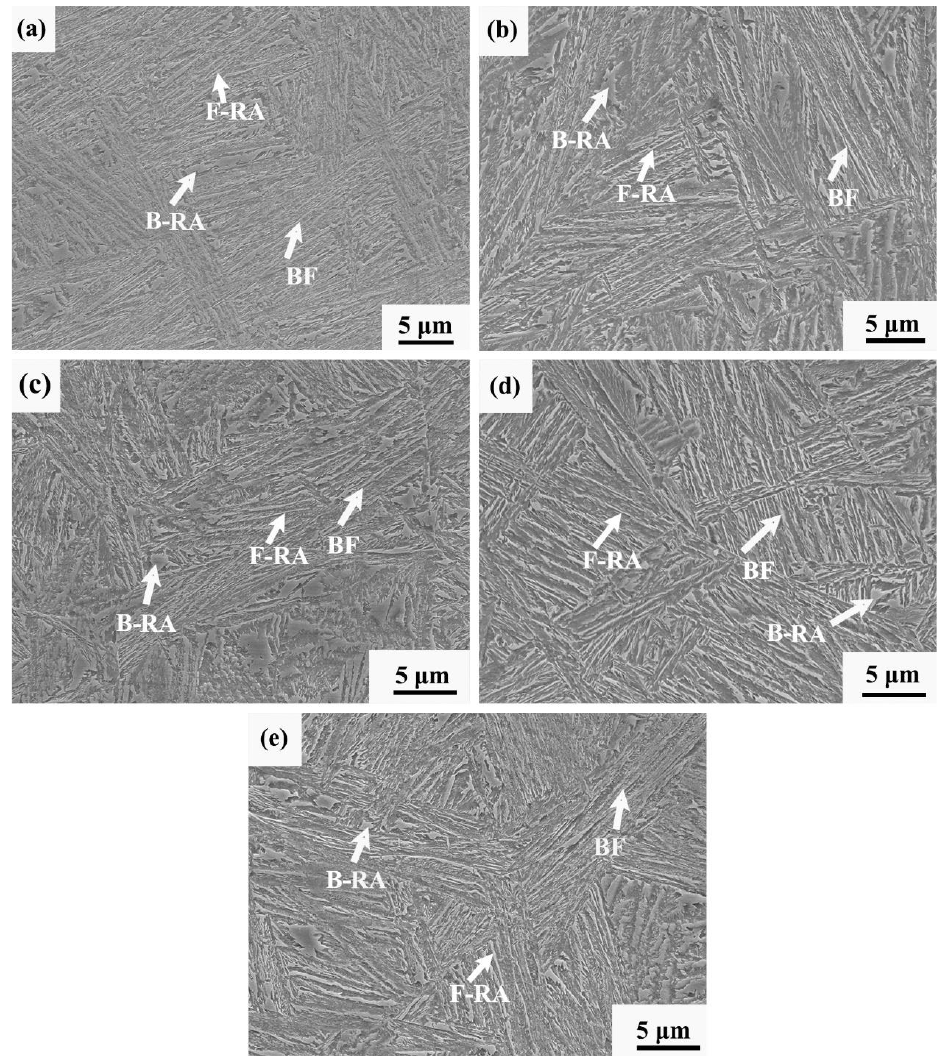
Figure 6. SEM micrographs of specimens with different heat treatment processes. ( a ) 950 °C; ( b ) 950 °C – 890 °C; ( c ) 950 °C – 870 °C; ( d ) 950 °C – 860 °C; and ( e ) 950 °C – 848 °C. (BF: bainitic ferrite; F-RA: film retained austenite; B-RA: blocky retained austenite)